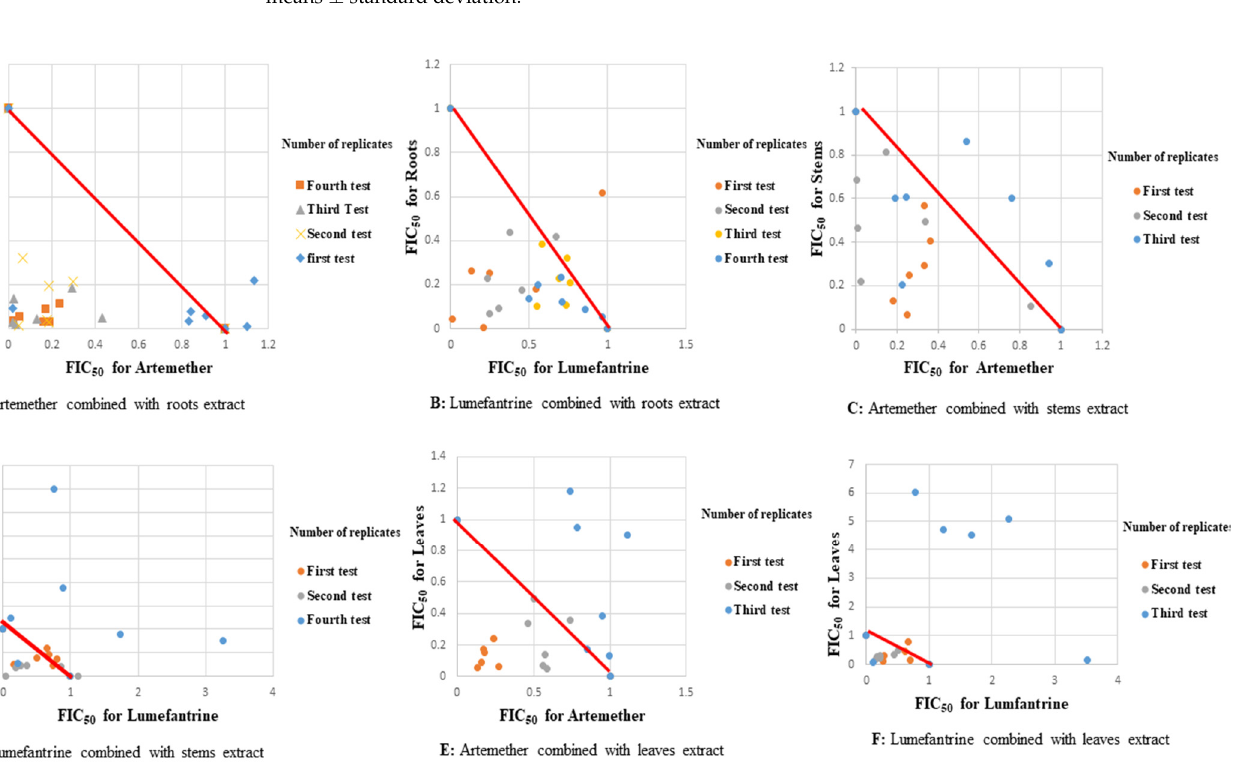
Figure 3. Scatter plots of drug-extract combinations against D6 strain of P. falciparum . Synergism was observed at all fixed ratios of artemether-stems extract when tested against field isolates ex vivo (Table 4). The artemether-leaves extract combination at fixed ratio of 3:1 also showed synergism with a mean sum FIC 50 value of 0.289 ± 0.155 against field isolates ex vivo (Table 4). Similar synergistic responses were observed at all the fixed doses of artemether-roots extract and lumefantrine-stems extract combinations against field isolates ex vivo except at a fixed ratios of 1:4 and 1:1 respectively which showed antagonism (Figure 4). Table 4. Mean sum FIC 50 values for artemether and lumefantrine combinations with S. longipedunculata against field iso- lates ex vivo.